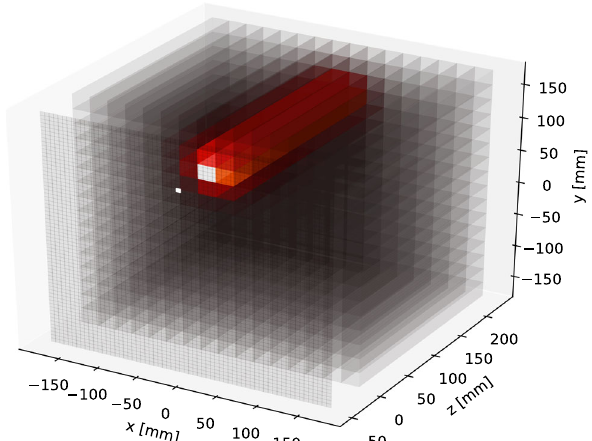
Fig. 3 Detector layout. The calorimeter comprises 16 × 16 lead tungstate cells and its front face is placed at z = 0, while the tracker is approximated by a grid of 64 × 64 silicon sensors, placed at z = − 5 cm. The colour palette indicates logarithmic energy deposits of an electron, scaled for the tracker sensors, where black corresponds to zero, red to intermediate, and white to the maximum